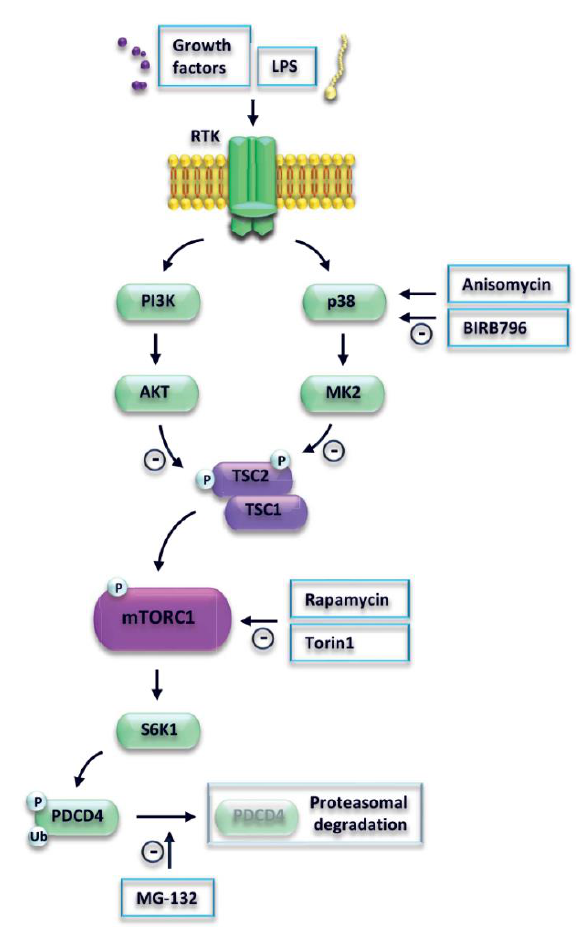
FIGURE 4: Model of p38 and mTORC1-mediated regulation of PDCD4. LPS activates Toll-like receptor 4 (TLR4) signaling. Subse- quent signal transmission via phosphoinositide 3-kinase (PI3K) and mitogen-activated kinase p38 leads to inhibition of the sup- pressor protein tuberous sclerosis complex 2 (TSC2), followed by activation of mammalian target of rapamycin complex 1 (mTORC1). mTORC1 phosphorylates ribosomal protein S6 kinase beta-1 (S6K1), which in turn phosphorylates programmed cell death protein 4 (PDCD4). PDCD4 is ubiquitinated and degraded by the